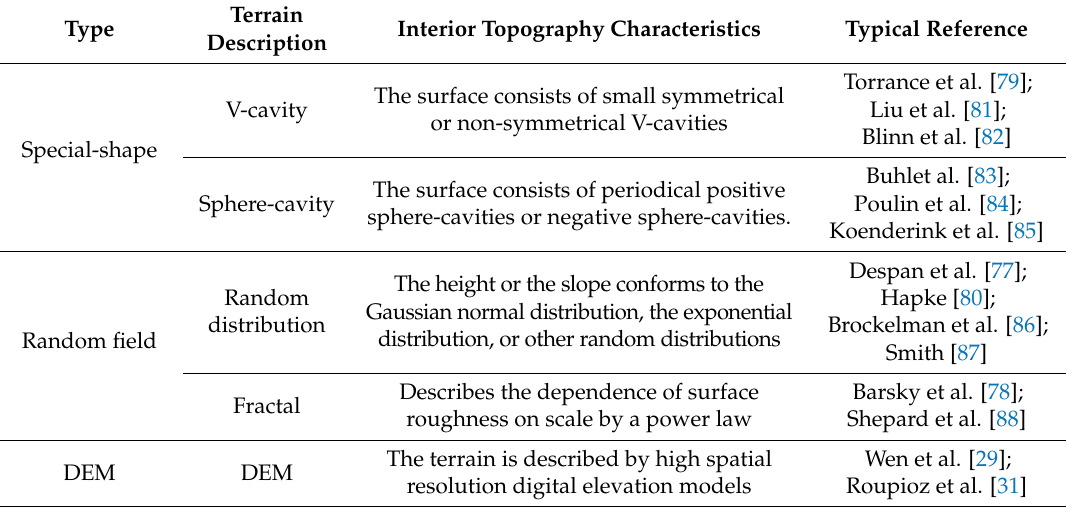
Table 2. Overview of composite slope BRDF models.